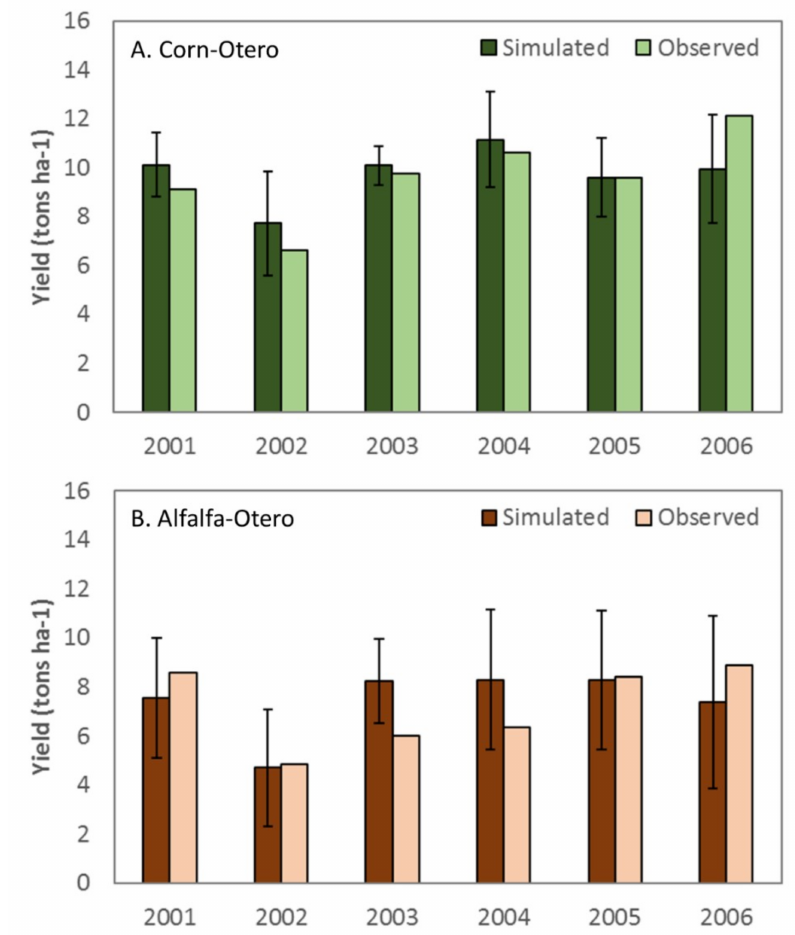
Figure 13. Average ( A ) corn and ( B ) alfalfa comparison between NASS reported and simulated values in Otero County over the 2001–2006 time period. Upper and lower bars indicate one standard deviation derived from simulated